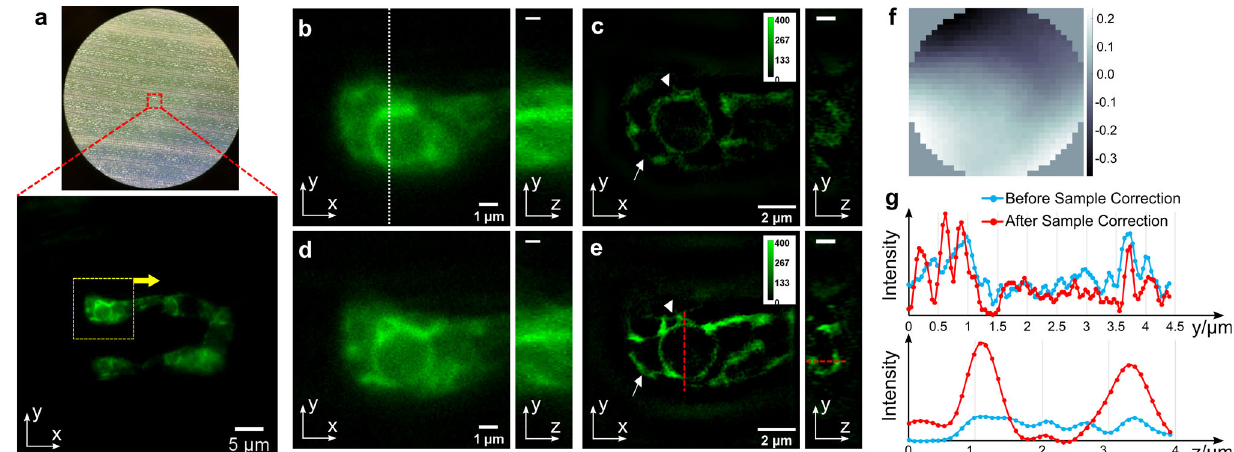
Fig. 5 GFP-labeled endoplasmic reticulum of live M. oryzae hyphal cells growing inside rice plant cells. a Bright fi eld image of the rice sheath tissue and the fl uorescence image of the GFP-labeled ER of hyphal cells. The yellow dashed-line square marks the area of interest in sample aberration correction. b Wide fi eld image with only system aberration corrected. c 3D-SIM image with only system aberration corrected. d Wide fi eld image with both sample and system aberrations corrected. e 3D-SIM image with both sample and system aberrations corrected. All x-y slices are in focus and the y-z slices are cross sections cut through the white dotted lines. f The corrective wavefront applied to the DM, units in microns. g Intensity pro fi le plotted across the red dashed lines along both the y and z axis in 3D-SIM images. Arrowheads indicate perinuclear ER and arrows indicate peripheral